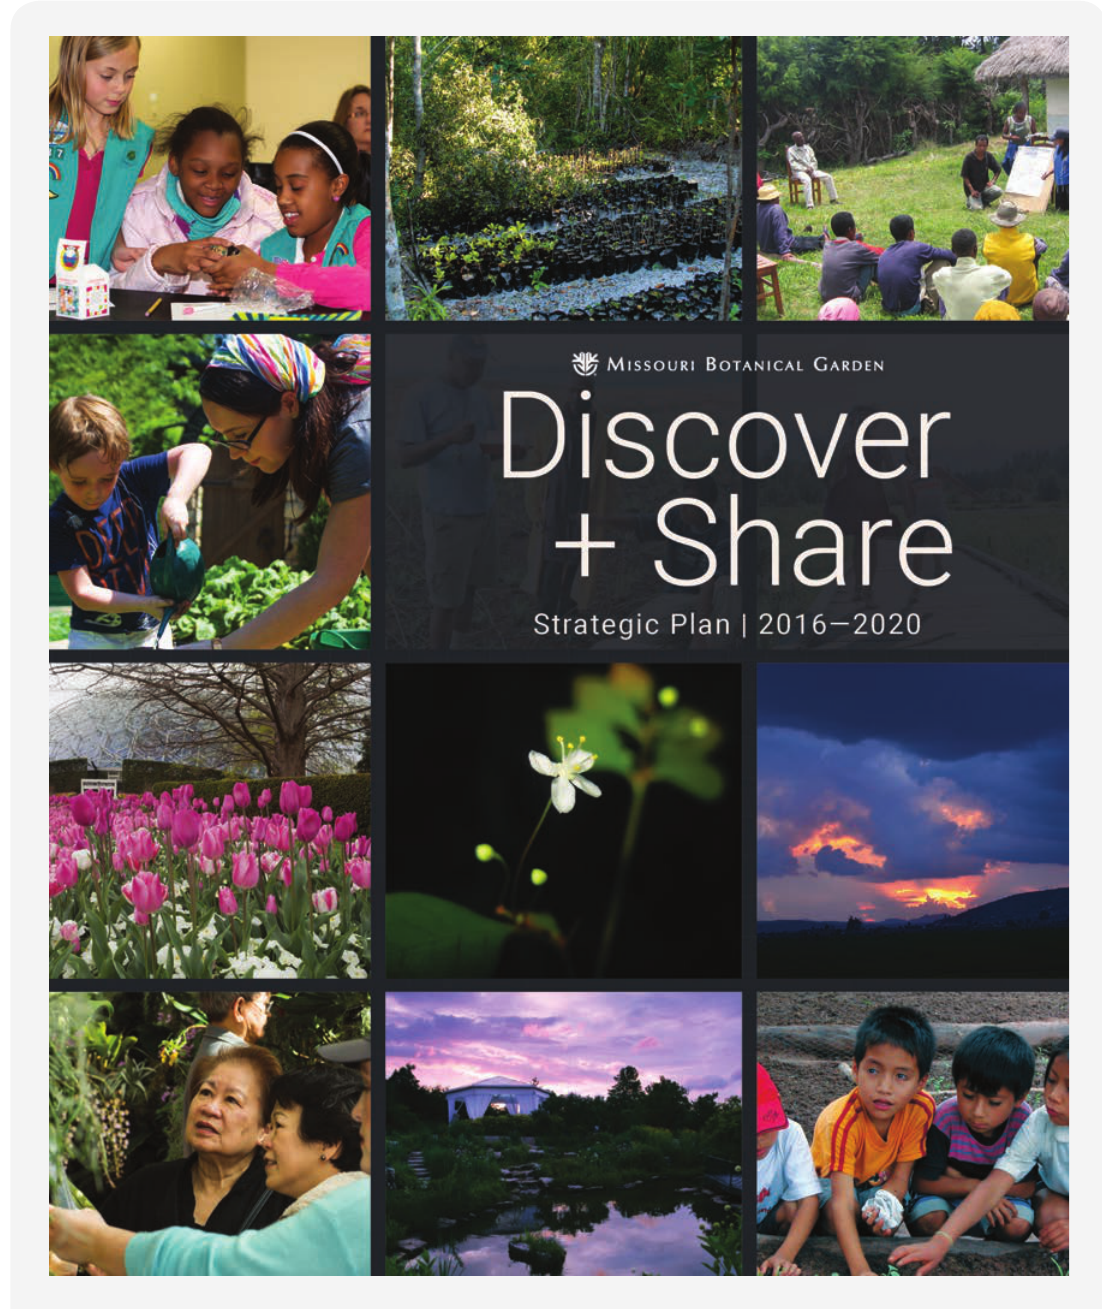
Figure 2. The Strategic Plan of the Missouri Botanical Garden, 2016–2020 provides the institutional direction and response to its institutional commitment to plant conservation locally, nationally, and